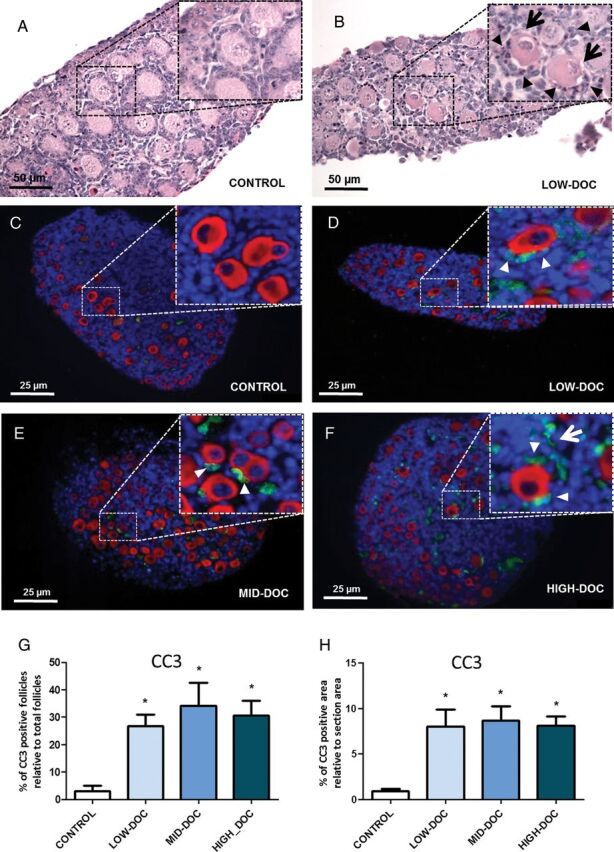
Docetaxel induces ovarian damage in mice activating caspase 3 in ovarian follicles and stroma. (A and B) Representative photomicrographs of mouse ovarian sections stained with haematoxylin and eosin. (A) CONTROL ovary showed mostly healthy follicles with no sign of GC damage. (B) Ovary treated with LOW-DOC showed several degenerating follicles, with pyknotic GCs (black arrowhead) and damaged follicles (black arrow). (C–F) Immunohistochemical localization of mouse vasa homologue (MVH: red) and cleaved caspase 3 (CC3: green), illustrating the degree and site of apoptosis. (C) CONTROL ovary exhibiting many MVH-positive oocytes but with little sign of CC3-positive apoptotic cells. (D–F) DOC-treated sections displayed marked apoptosis staining, with CC3 signal evident in many GCs (white arrowhead) and stroma (white arrow). Sections were counterstained with DAPI (blue). Insets represent magnified images of respective framed areas. (G and H) Analysis of immunohistochemistry for CC3. DOC-treated ovaries showed significantly increased expression of CC3 whether analysed (G) manually or (H) semi-automatically. (G) Percentage of follicles containing CC3-positive cells. (H) Area of CC3-positive cells relative to area of section. Total of ovaries used in three independent experiments: CONTROL= 5, LOW-DOC = 5, MID-DOC = 5 and HIGH-DOC = 4. Kruskal–Wallis followed by Dunn post hoc tests were applied. Data are mean ± SEM. P < 0.05 (*) for DOC versus CONTROL.